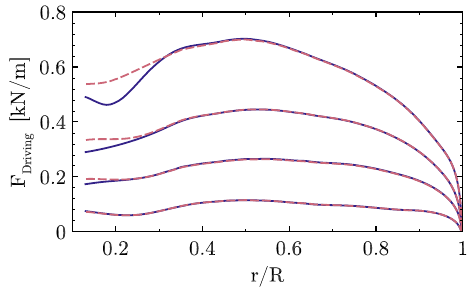
Figure 35. Influence of different wind speeds on the sectional thrust force. CaseT1.0 (solid), CaseT1.0-fairing (dashed). Table 1. Integral blade forces and torque for CaseT1.0 and CaseT1.0-fairing at different wind speeds.